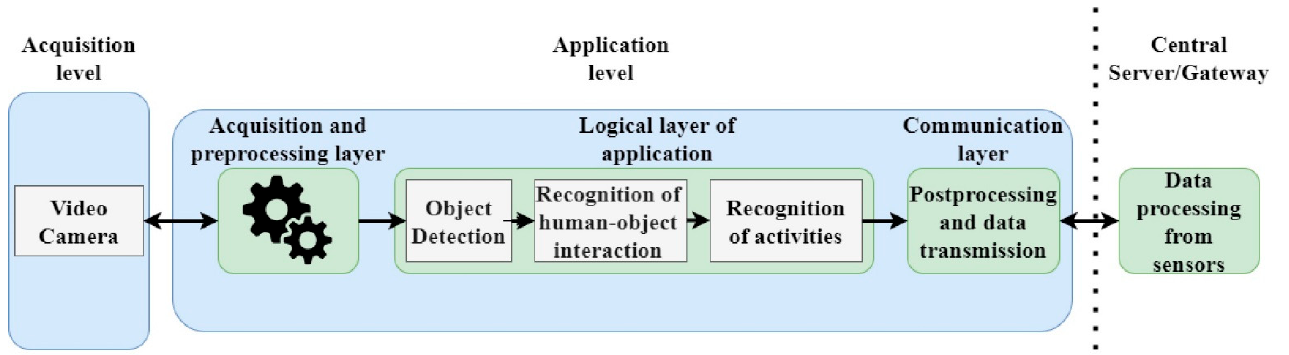
Figure 6. Hardware and software architecture.